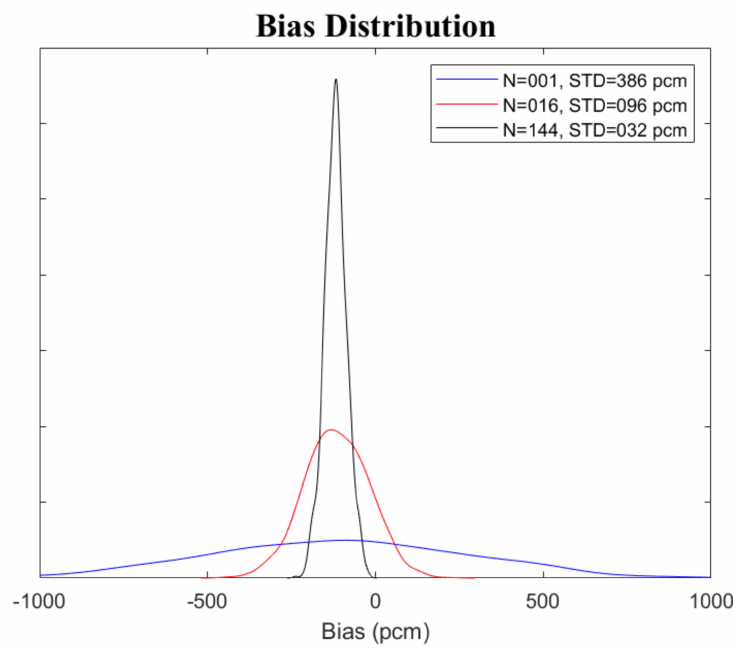
Figure 6. Mean estimation of application bias.